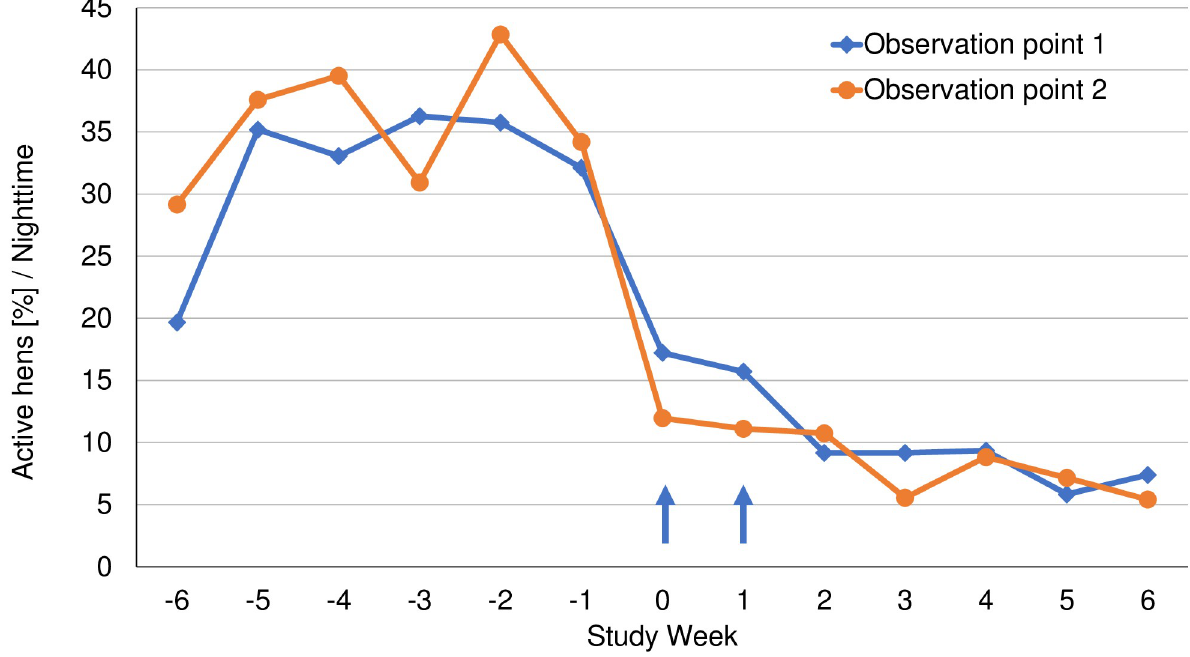
Fig 2. The percent of active hens observed in night-time video recordings for each observation point. Arrows indicate days of fluralaner administration (Weeks 0 and 1).